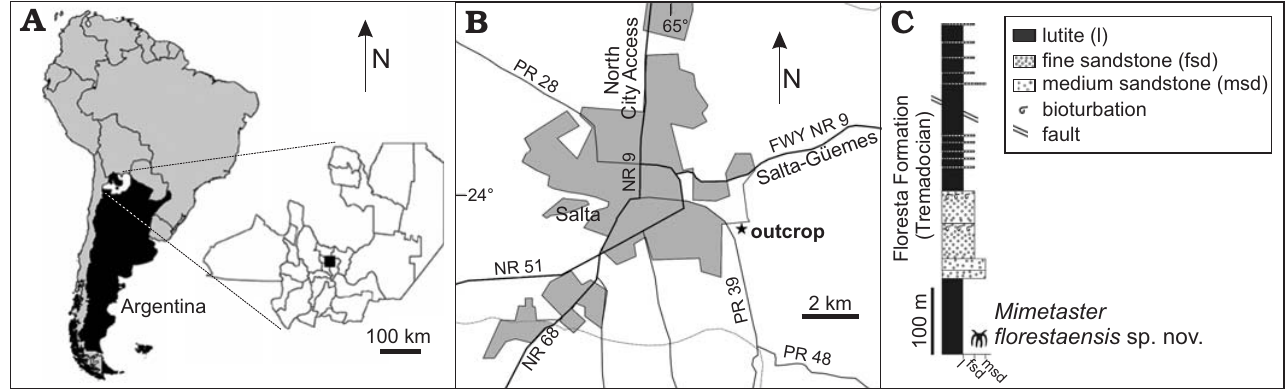
Fig. 1. Geographic map ( A ) and location of the studied area ( B ) and stratigraphic provenance of the material ( C